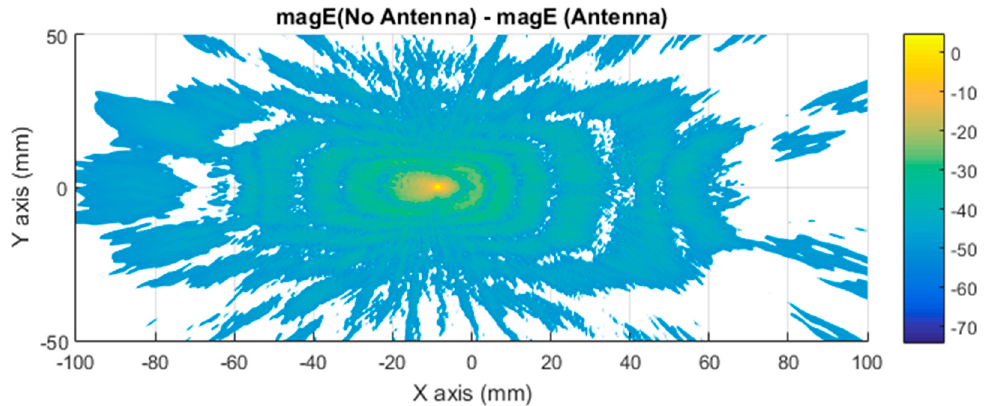
Figure 9. Distribution of near electric field difference between a vehicle with and without antenna magnified (in logarithmic scale) for the three components evaluated across a plane in contact with the top of the car, illuminated at 300 GHz.